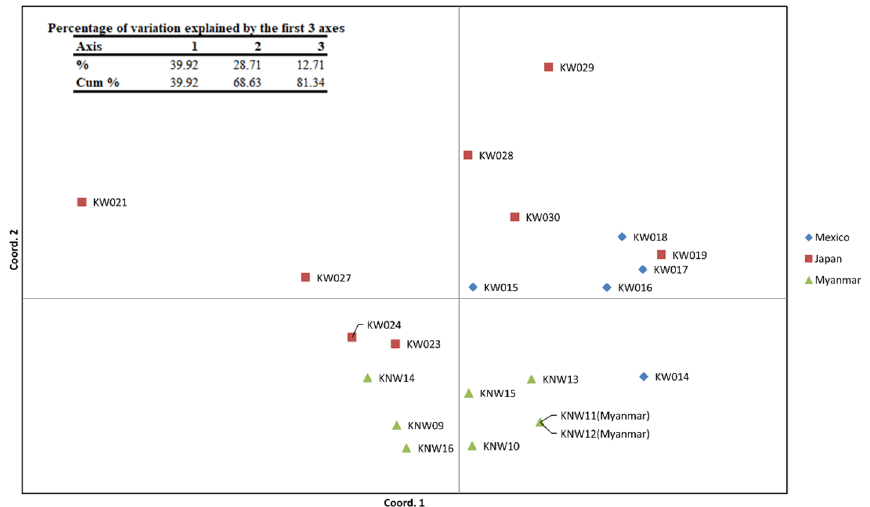
Figure 4. The principal coordinate analysis (PCoA) of twenty-one S. edule accessions based on the SSR data. The first three axes of PCoA explained 81.34% of variations.